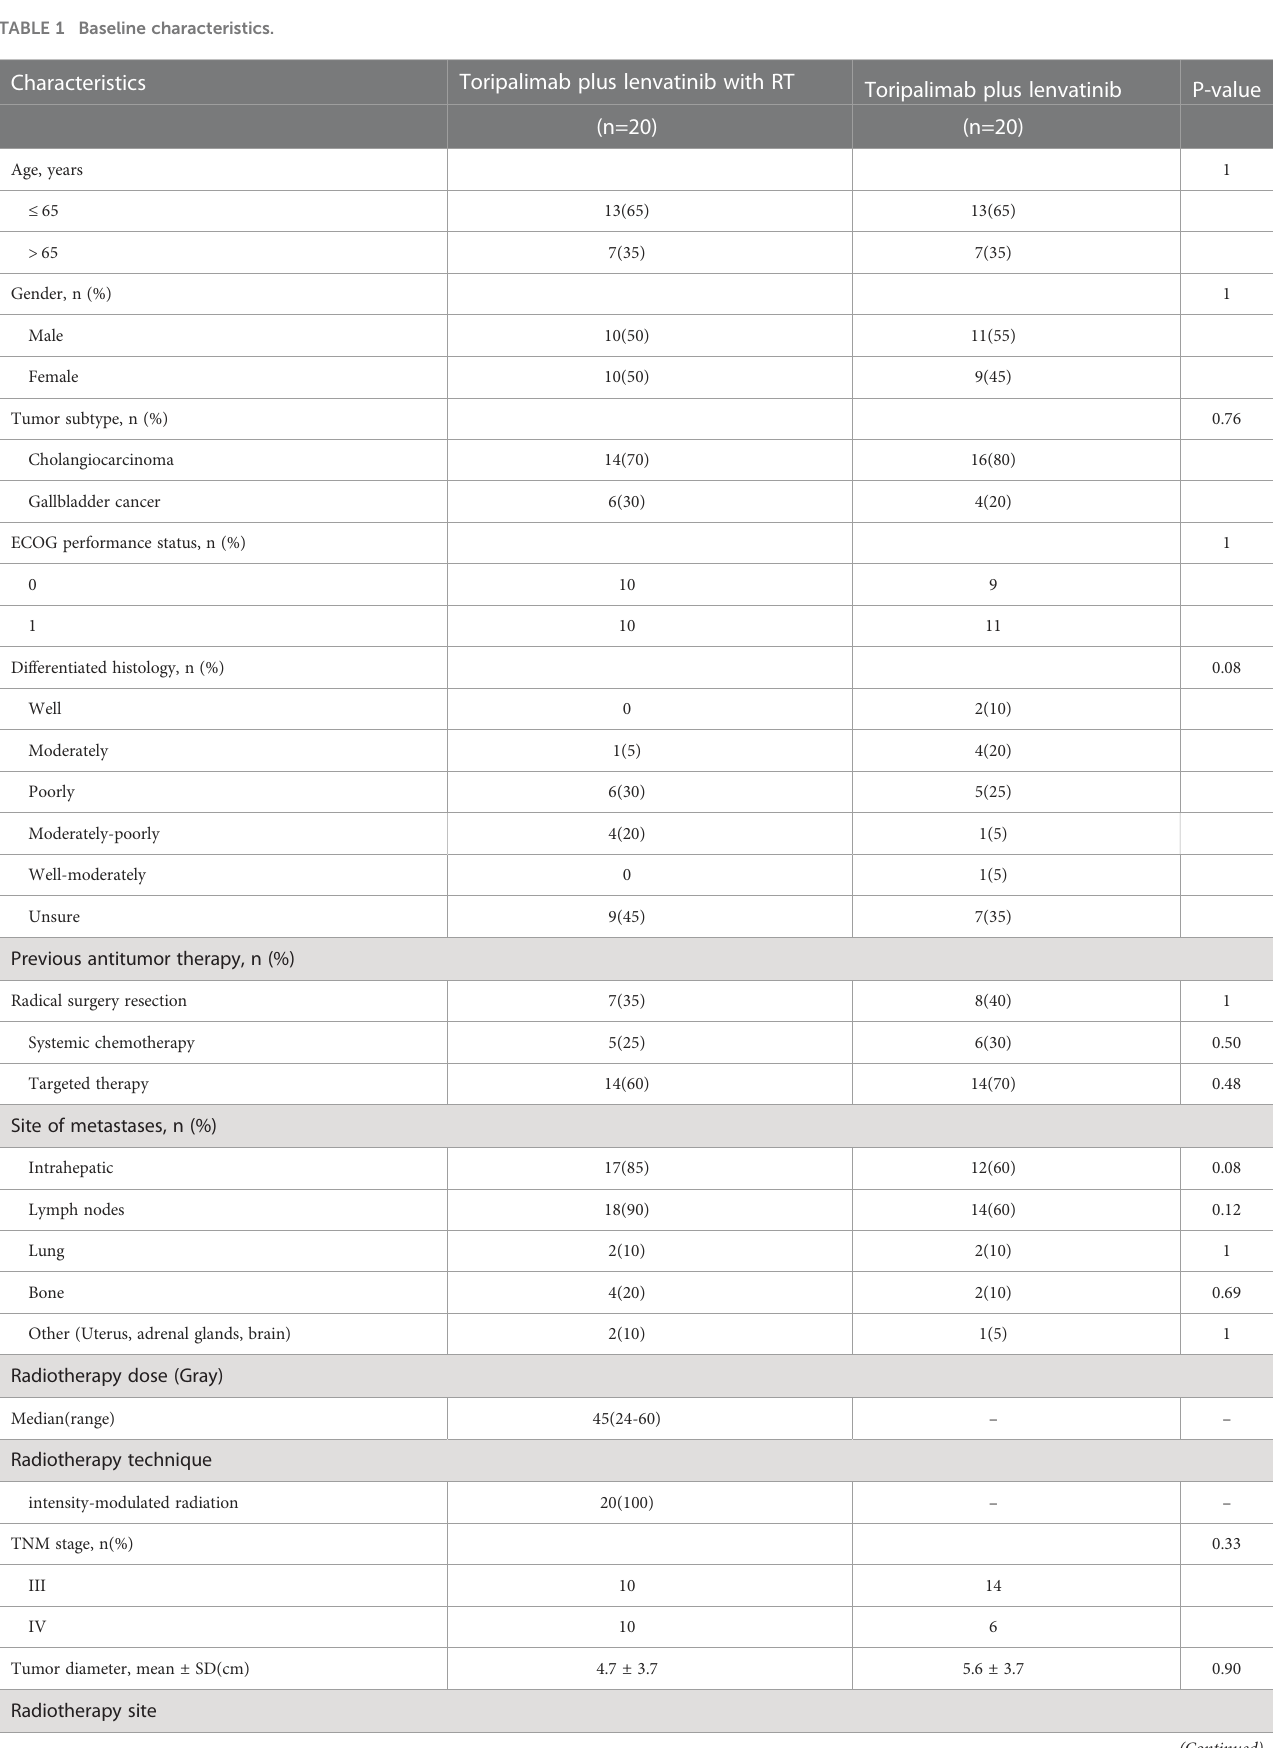
TABLE 1 Baseline characteristics.